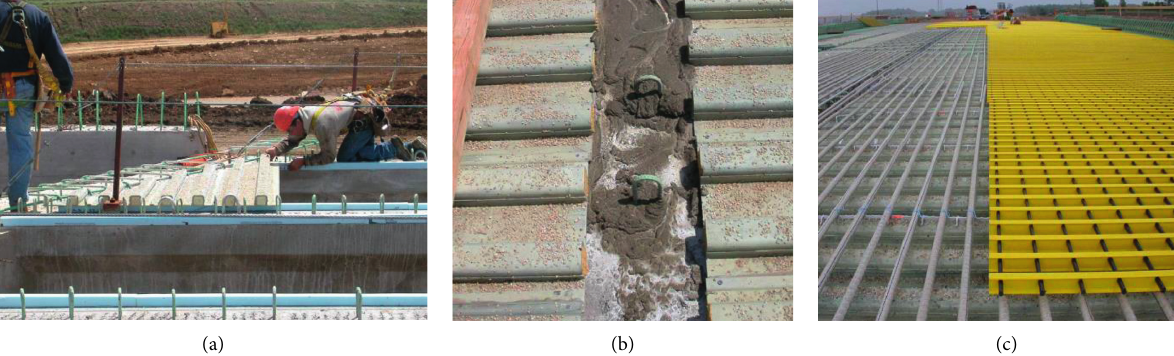
Figure 16: The hybrid beam system applied in Wisconsin, USA. (a) SIP FRP deck panel placement. (b) Roughened grout between SIP FRP deck panels. (c) FRP bars and grid placement.